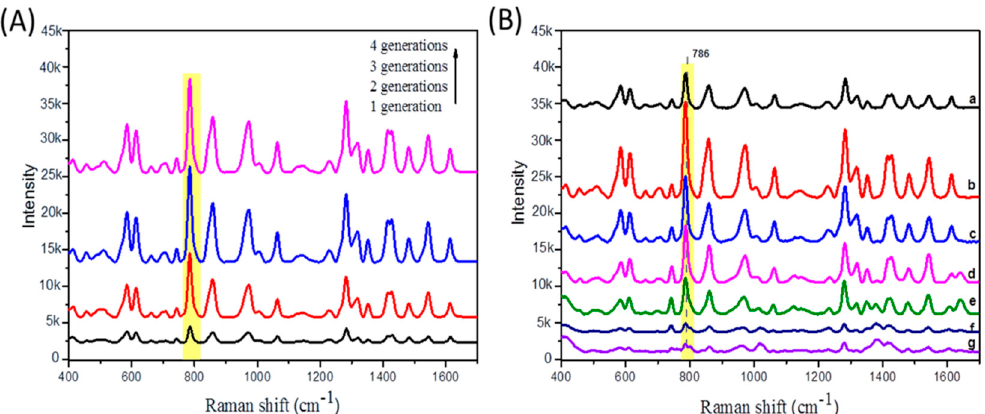
Figure 4. ( A ): SERS spectra of flumetsulam adsorbed on four different AuNPs substrates with different growth generations (1–4 generations). ( B ): SERS spectra of flumetsulam adsorbed on AuNPs substrates with different concentration factors (a: 1×, b: 2×, c: 5×, d: 10×, e: 20×, f: 40×, g: 100×).